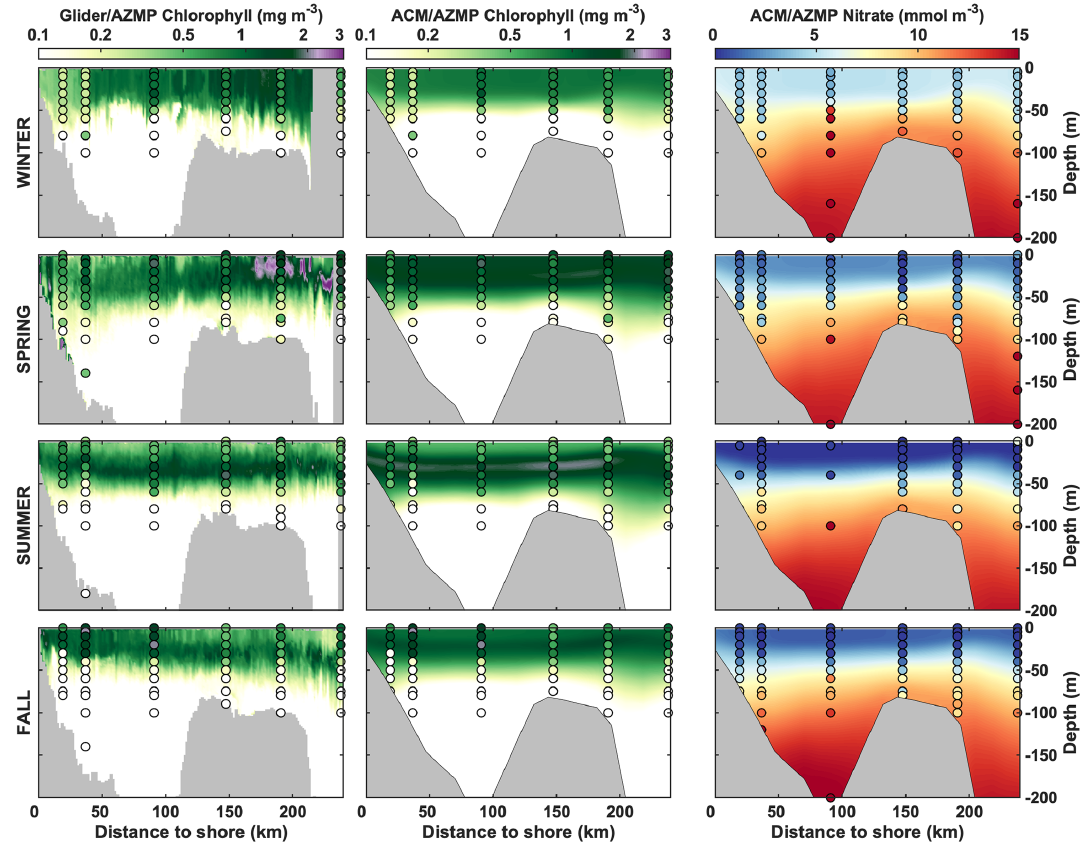
Figure 9. Comparison of gliders, AZMP and model seasonal climatologies of chlorophyll and nitrate along the Halifax Line.